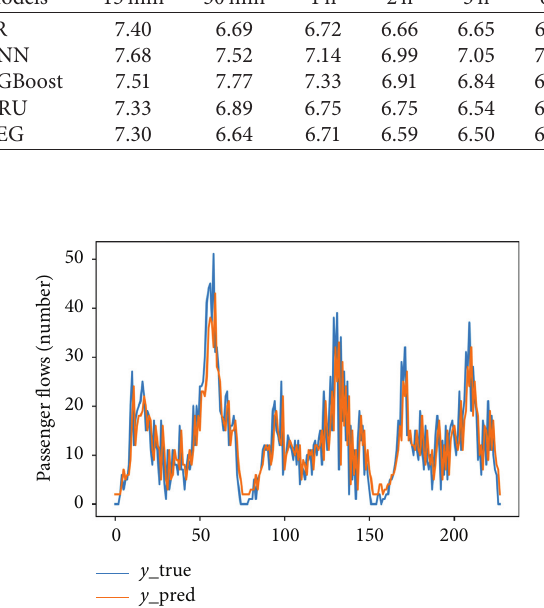
Figure 8: Regression integration prediction results when the time step is 15min.